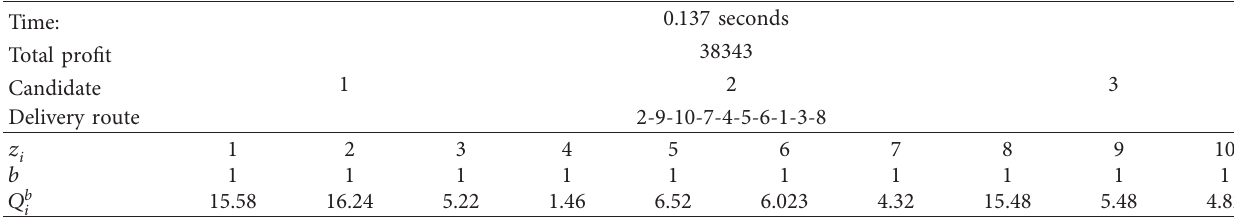
Table 5: The heuristic algorithm based on GA by MATLAB calculation results.